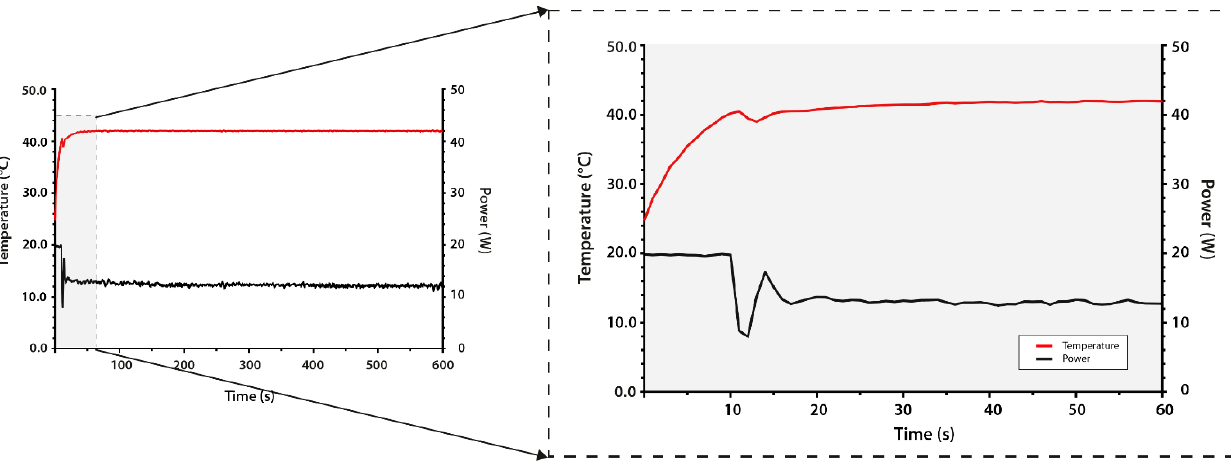
Figure 13. Infrared images of the in vivo region of interest during initial hyperthermia application. In panel 1, the animal is marked by the thin dashed line, the antenna is marked by a dashed line and indicated with a closed arrow head, and the arrows indicate the needle-tip thermometers. The region of interest is marked in each panel by the dashed box.